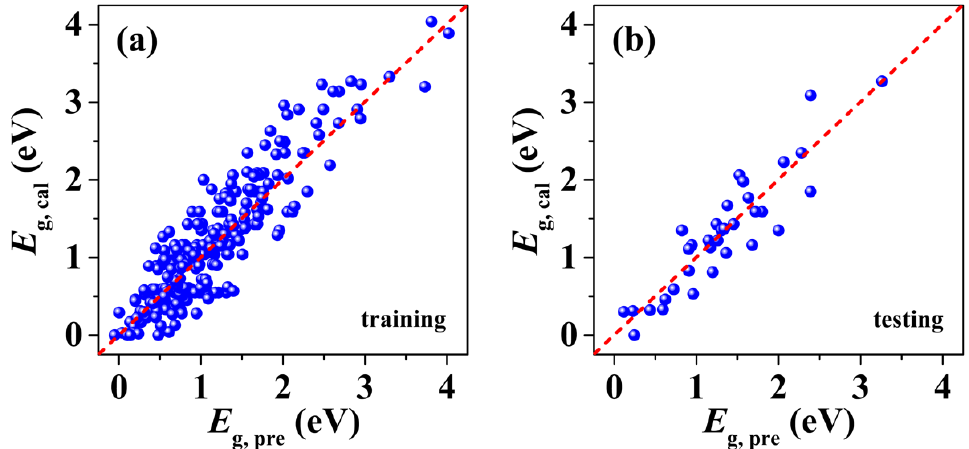
Figure 2. The intuitive linear correlation between the SISSO-predicted band gaps and those calculated by first-principles for vdWHs in the ( a ) training data and ( b ) testing data. The red dashed line represents equality.